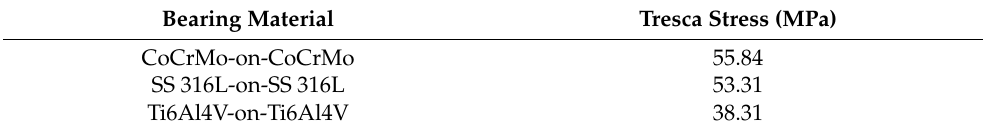
Table 4. Maximum Tresca stress for different metal-on-metal bearing materials at peak